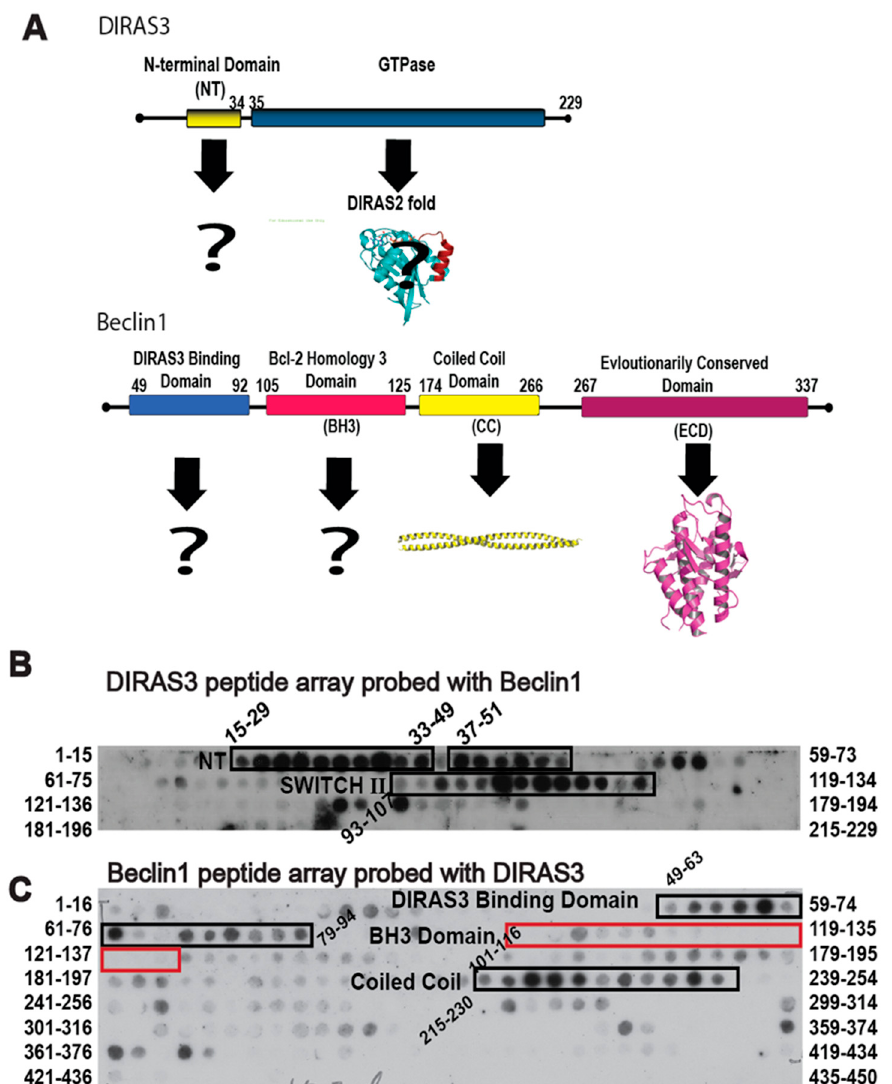
Figure 1. DIRAS3 and BECN1 domain organization and peptide overlay. ( A ) Functional domains are shown with their boundaries marked with residue numbers. Crystal structures of the CC and ECD domains are shown. ( B ) Beclin1 overlay of a peptide array comprising residues 1–229 of DIRAS3. ( C ) DIRAS3 overlay of a peptide array comprising residues 1–450 of Beclin1. A 16mer peptide array staggering every other residue was probed with DIRAS3. The BH3 domain (105–125, red box) of Beclin1, which binds Bcl-2, does not bind DIRAS3.